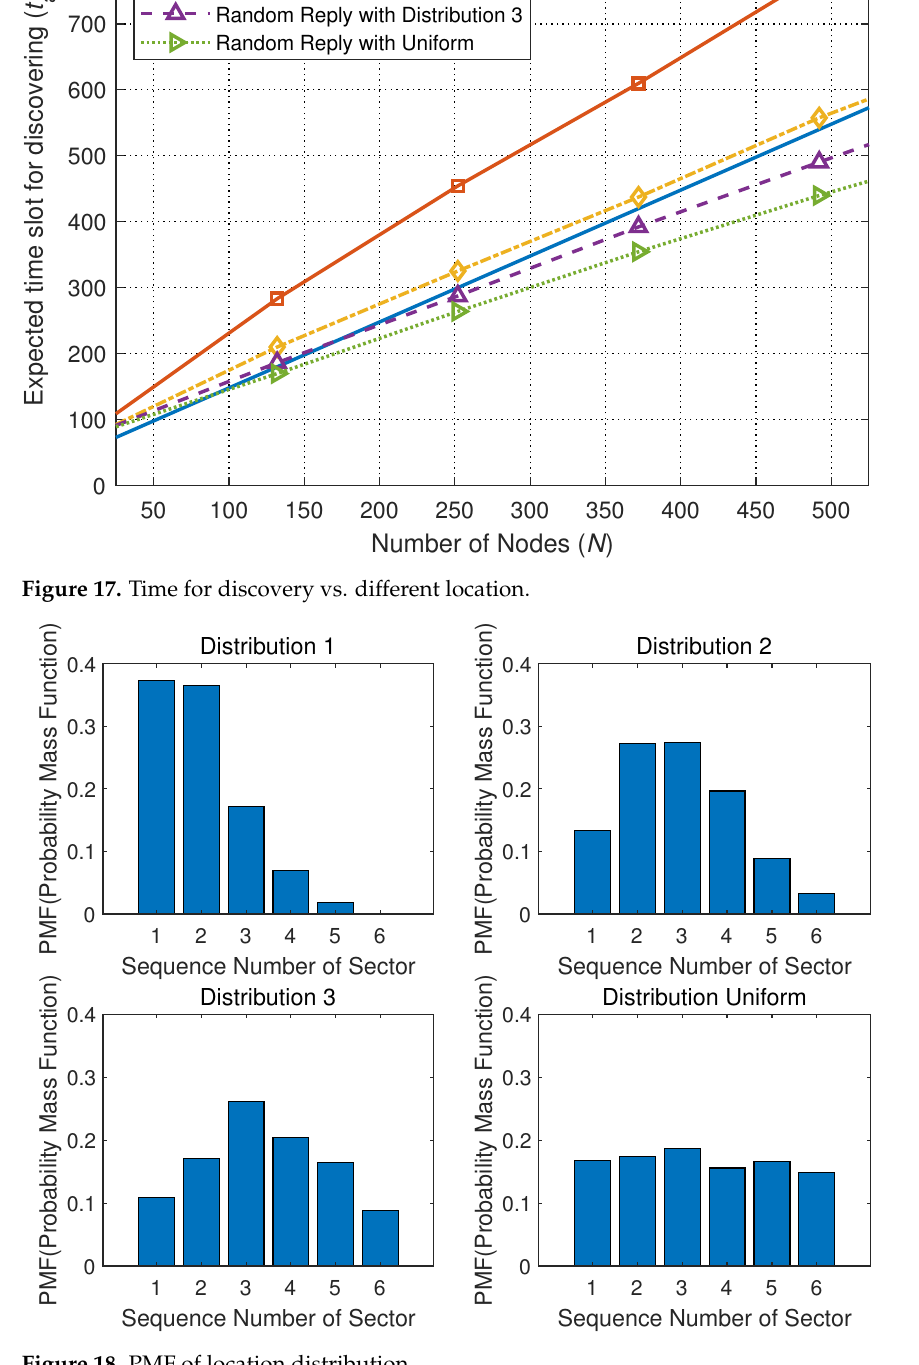
Figure 18. PMF of location